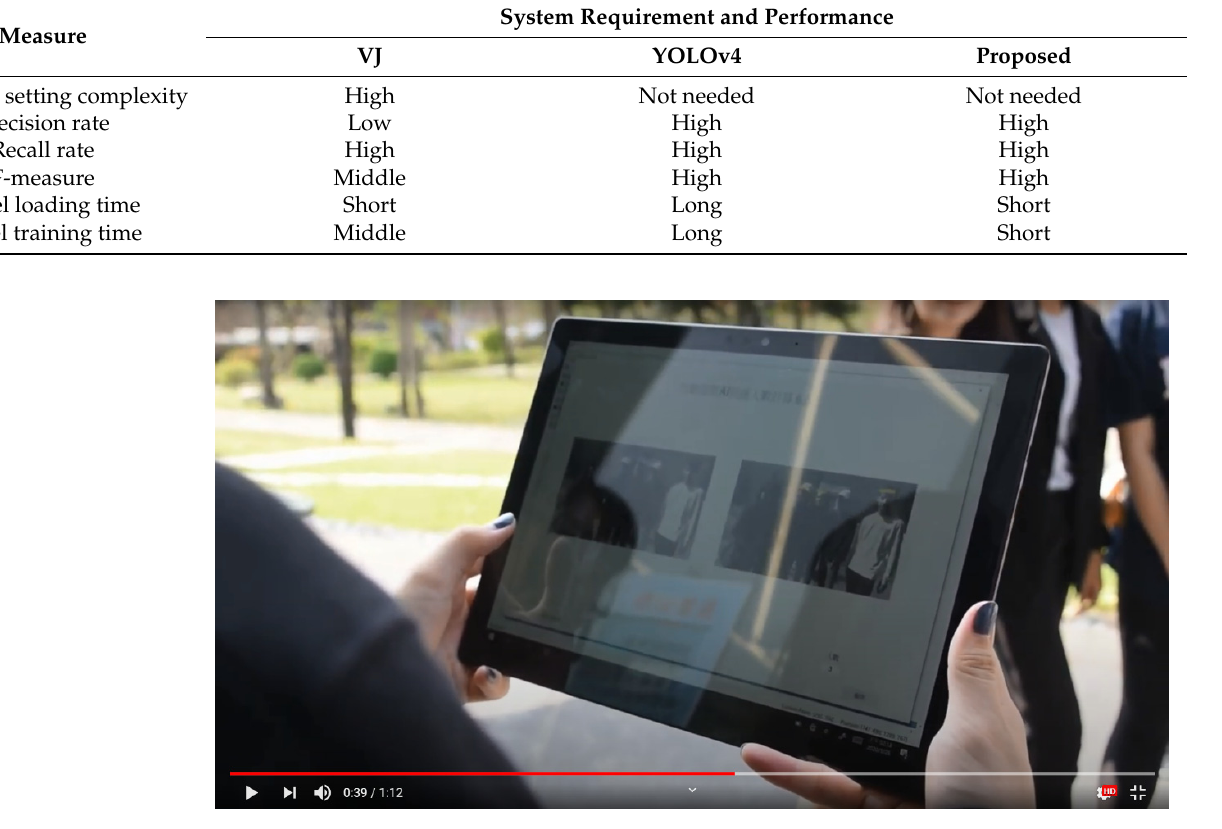
Figure 9. An example of using the proposed app for calculating the number of people.